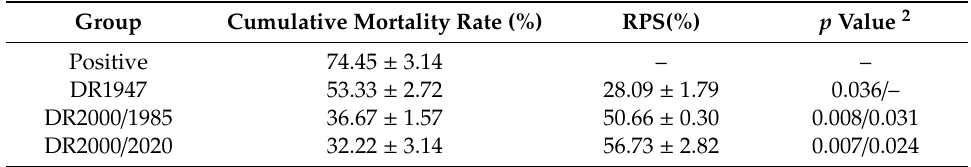
Table 3. Cumulative mortality rate and RPS of grass carp challenged with GCRV